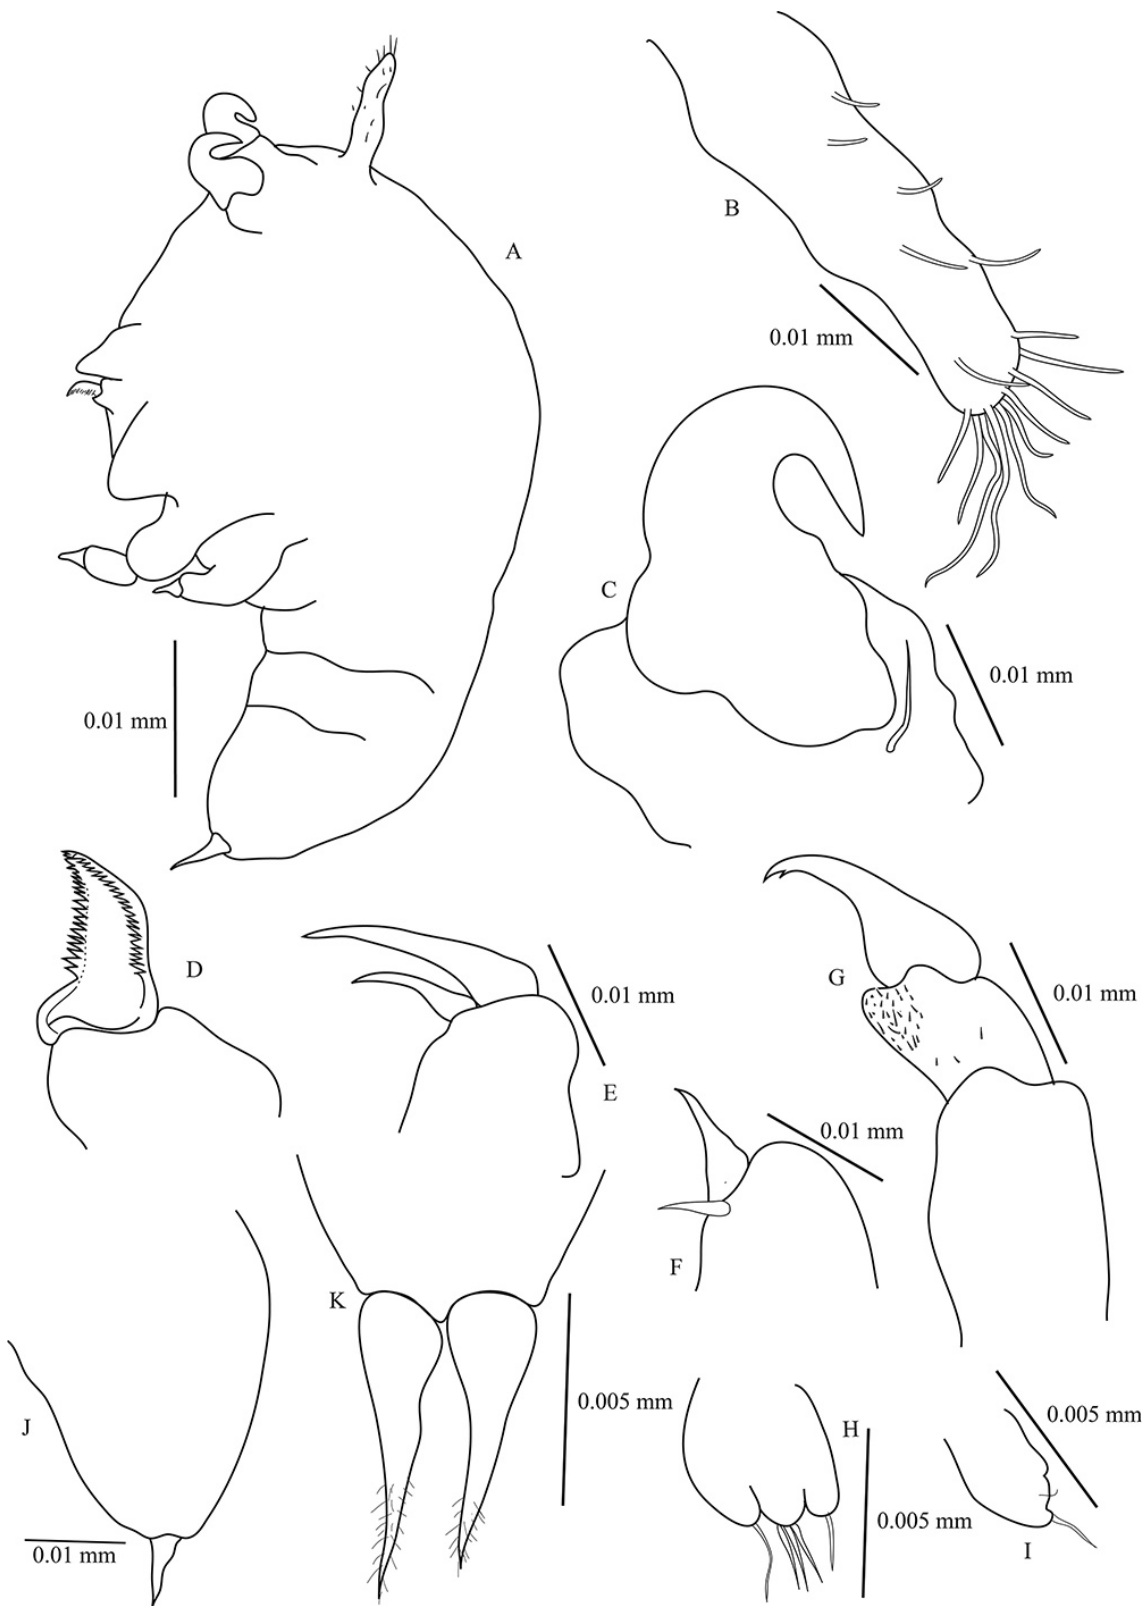
Figure 6. Acanthochondria krishnai sp. n., non-type male from Uranoscopus guttatus Cuvier. A . Habitus lateral view. B . Antennule. C . Antenna. D . Mandible. E . Maxillule. F . Maxilla. G . Maxilliped. H . Leg 1. I . Leg 2. J . Lateral view of genito-abdomen. K . Ventral view of